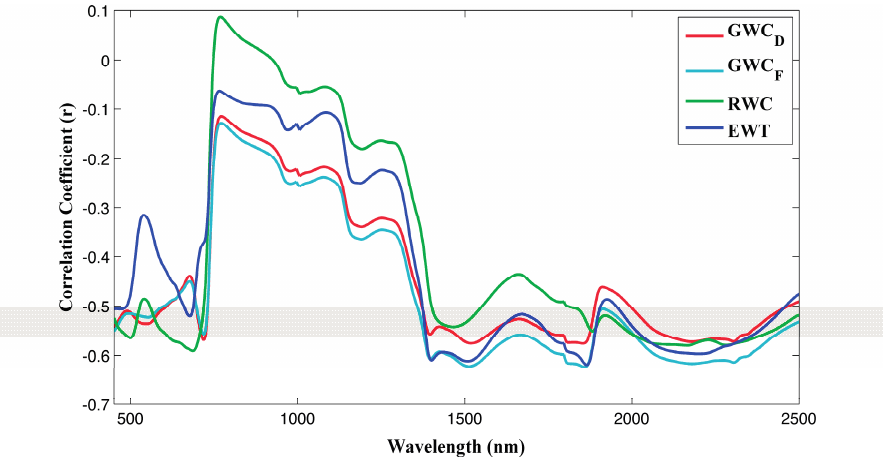
Figure 3. Correlations between reflectance at all wavelengths and GWC D , GWC F , RWC, EWT at leaf level of winter wheat. The significant correlation ( p < 0.001) was indicated by r greater than 0.45 or less than − 0.45 (140 samples).